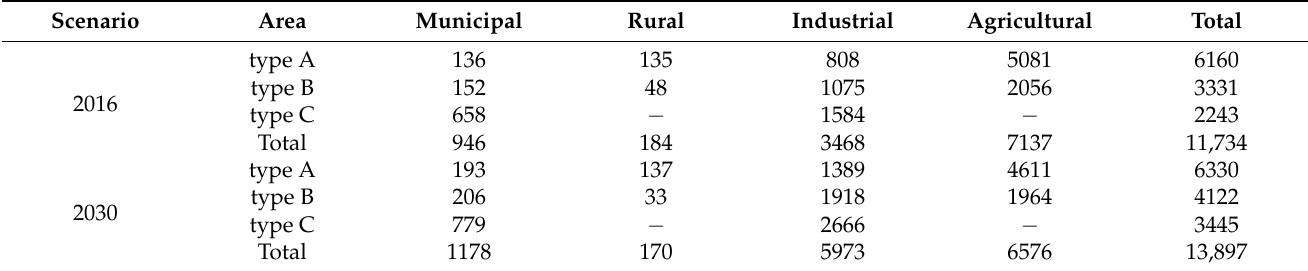
Table 5. Water demands of the socioeconomic water use in 2016 and 2030 (million m 3 ). Scenario